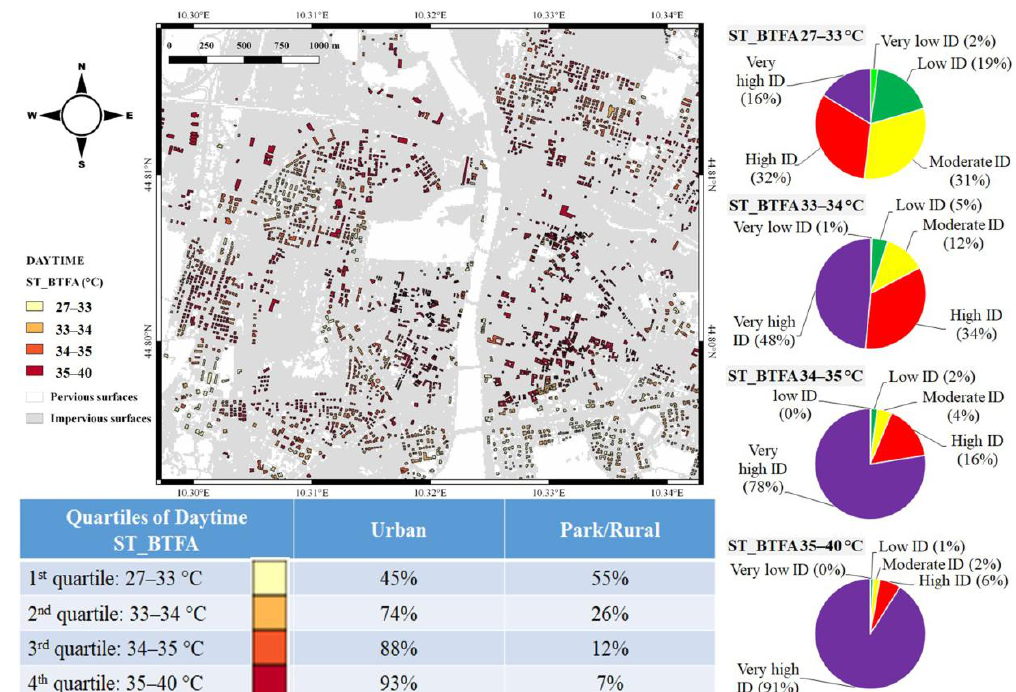
the low ID group, subsequent progressive significant ( p < 0.05) ST_BTFA increases among ID groups were observed, reaching the maximum ST_BTFA value in the very high ID group (Table 2).